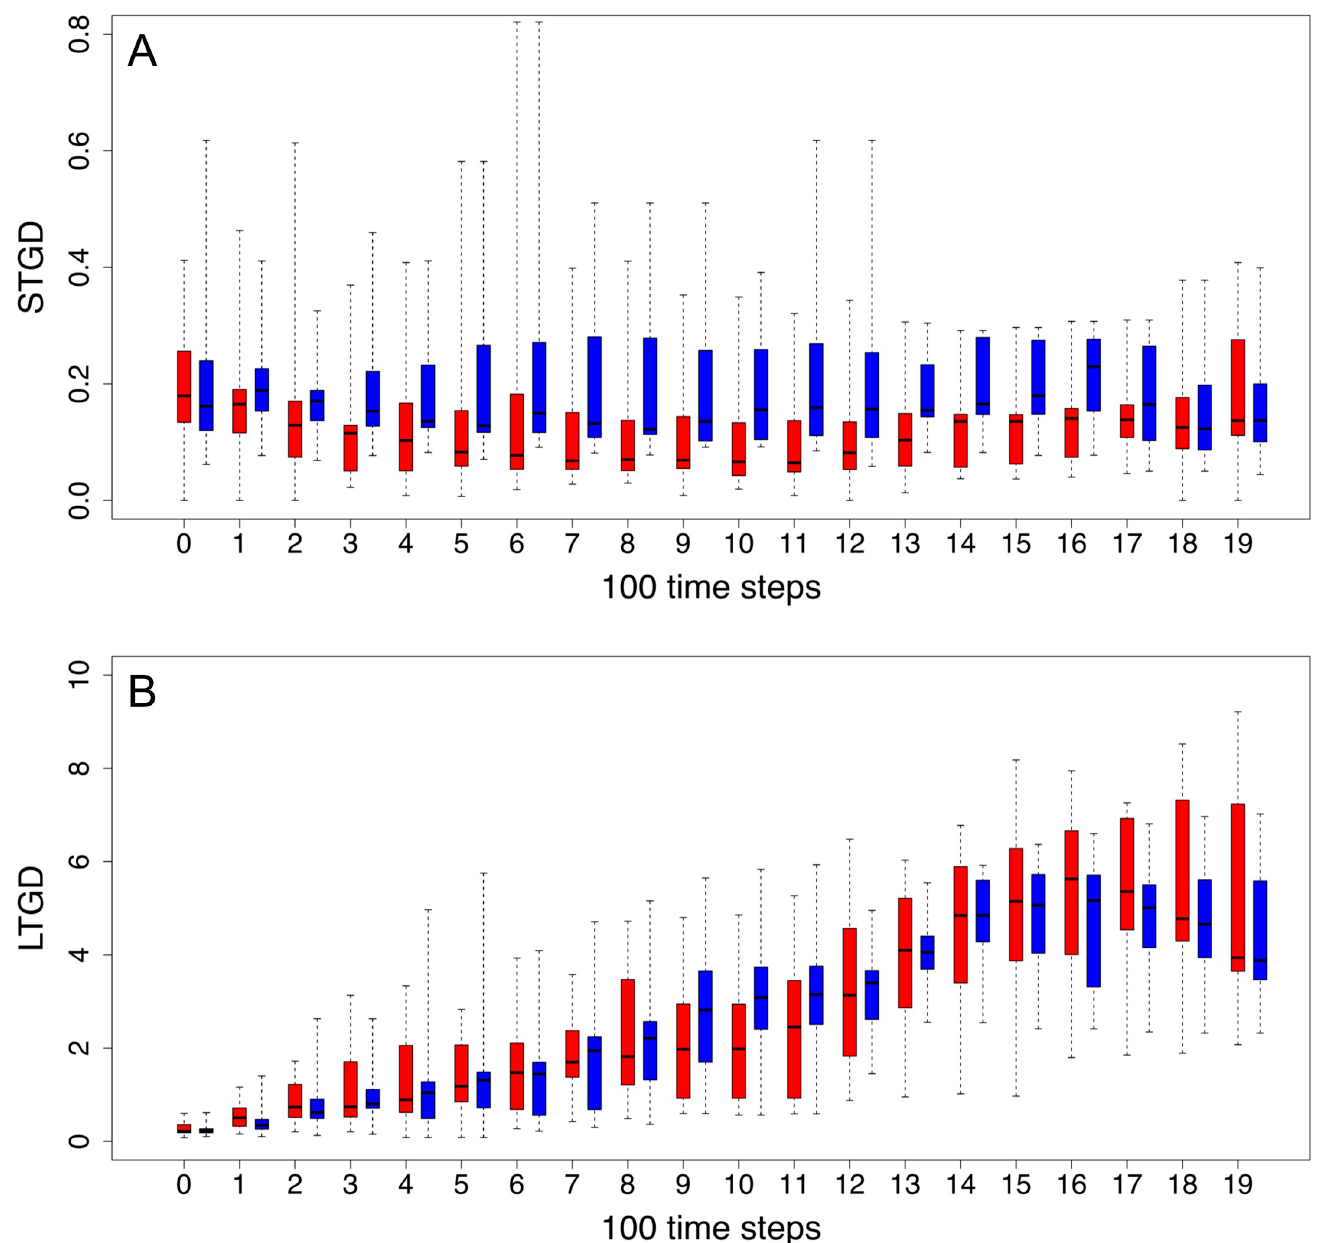
Fig 5. Evolution of short-term genetic distance (A, STGD) and long-term genetic distance (B, LTGD) across 30 experiments (simulations) under a dynamically changing environment (70% food reduction). To represent the evolution of STGD (A) and LTGD (B) across the simulation experiment, average values for all genomes and simulations were computed, ascribed to bins of 100 time steps, and plotted separately for ‘adapted’ polyploid and non-polyploid populations as red and blue box plots, respectively. A two sample t -test was based on the same values, comparing polyploid and non-polyploid populations. Solid lines in box blots represent the median values of the STGD and LTGD of all simulations, while the box borders correspond to the first and third quartile and the extreme values correspond to the lowest and highest values observed in any of the simulations. See text for